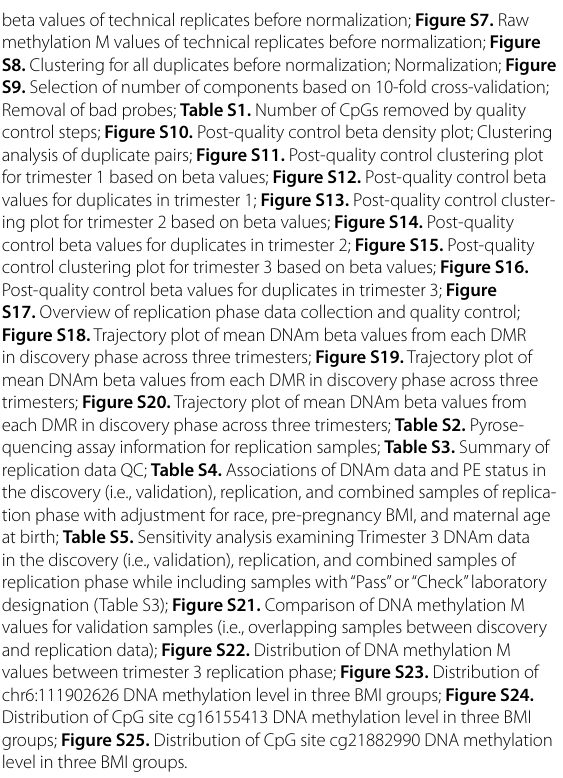
beta values of technical replicates before normalization; Figure S7. Raw methylation M values of technical replicates before normalization; Figure S8. Clustering for all duplicates before normalization; Normalization; Figure S9. Selection of number of components based on 10-fold cross-validation; Removal of bad probes; Table S1. Number of CpGs removed by quality control steps; Figure S10. Post-quality control beta density plot; Clustering analysis of duplicate pairs; Figure S11. Post-quality control clustering plot for trimester 1 based on beta values; Figure S12. Post-quality control beta values for duplicates in trimester 1; Figure S13. Post-quality control cluster- ing plot for trimester 2 based on beta values; Figure S14. Post-quality control beta values for duplicates in trimester 2; Figure S15. Post-quality control clustering plot for trimester 3 based on beta values; Figure S16. Post-quality control beta values for duplicates in trimester 3; Figure S17. Overview of replication phase data collection and quality control; Figure S18. Trajectory plot of mean DNAm beta values from each DMR in discovery phase across three trimesters; Figure S19. Trajectory plot of mean DNAm beta values from each DMR in discovery phase across three trimesters; Figure S20. Trajectory plot of mean DNAm beta values from each DMR in discovery phase across three trimesters; Table S2. Pyrose- quencing assay information for replication samples; Table S3. Summary of replication data QC; Table S4. Associations of DNAm data and PE status in the discovery (i.e., validation), replication, and combined samples of replica- tion phase with adjustment for race, pre-pregnancy BMI, and maternal age at birth; Table S5. Sensitivity analysis examining Trimester 3 DNAm data in the discovery (i.e., validation), replication, and combined samples of replication phase while including samples with “Pass” or “Check” laboratory designation (Table S3); Figure S21. Comparison of DNA methylation M values for validation samples (i.e., overlapping samples between discovery and replication data); Figure S22. Distribution of DNA methylation M values between trimester 3 replication phase; Figure S23. Distribution of chr6:111902626 DNA methylation level in three BMI groups; Figure S24. Distribution of CpG site cg16155413 DNA methylation level in three BMI groups; Figure S25. Distribution of CpG site cg21882990 DNA methylation level in three BMI